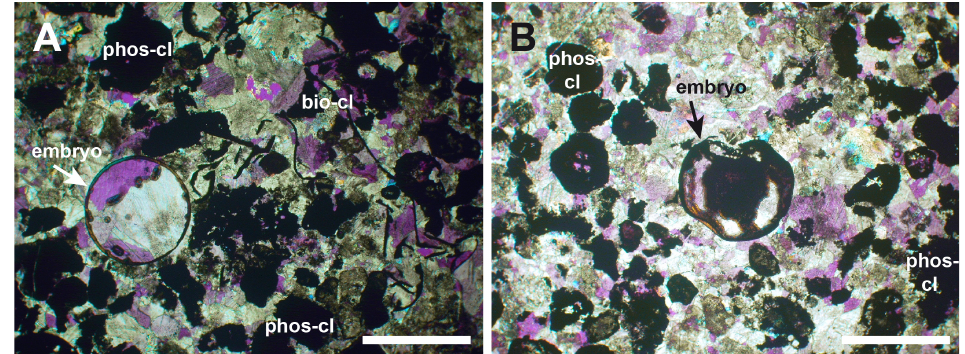
Fig. 2. Thin section photomicrographs (crossed polarized light) of an embryo-bearing layer, Kuanchuanpu section, China. (A) Phosphatized globular embryo fossil associated with phosphatic clasts and bioclasts in a coarse sparitic carbonate matrix. The embryo is preserved as a hollow cast cemented by carbonate. (B) Slightly collapsed and phosphatized embryo fossil partially filled with diagenetic calcium phosphate (scale bar: 600µm).